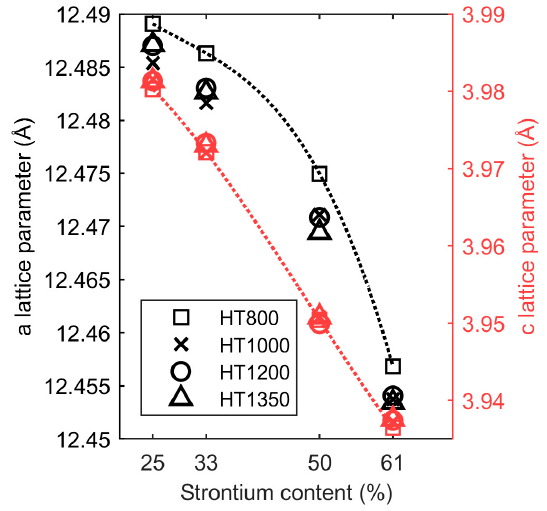
Figure 4. The a (black, left axis) and c (red, right axis) lattice parameters for all the compositions and heat treatments as calculated from the Rietveld refinements in TOPAS.